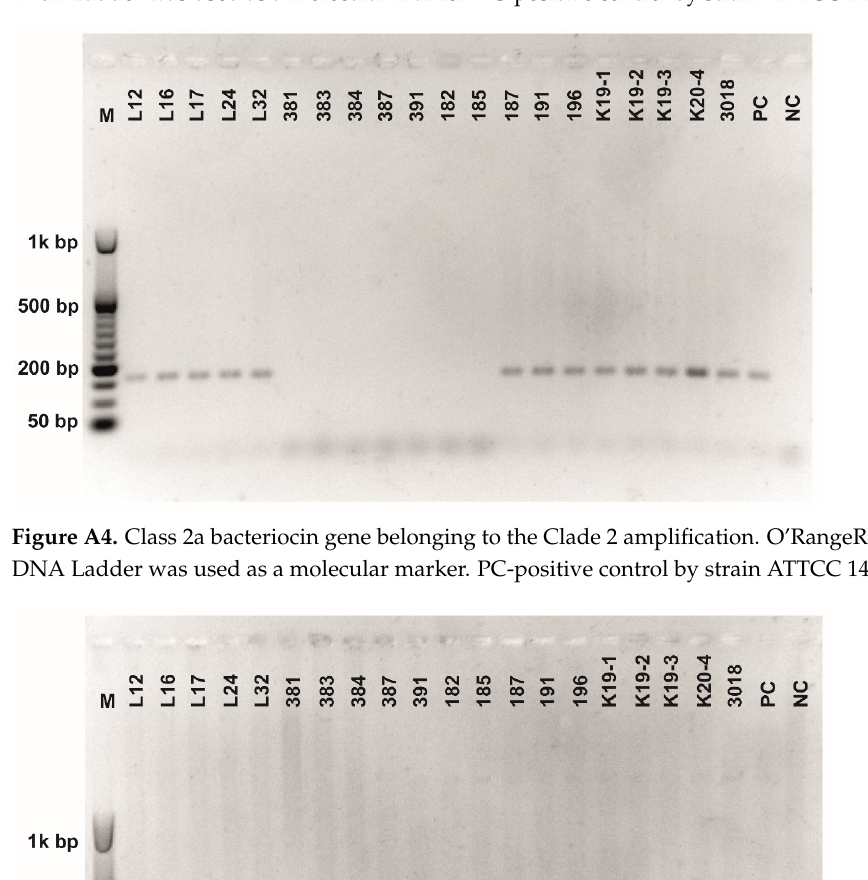
Figure A6. Class 2a bacteriocin gene belonging to the Clade 4 amplified using second primer pair (Table 3). O’RangeRuler TM 50 bp DNA Ladder was used as a molecular marker. PC-positive control by strain ATTCC 14917.